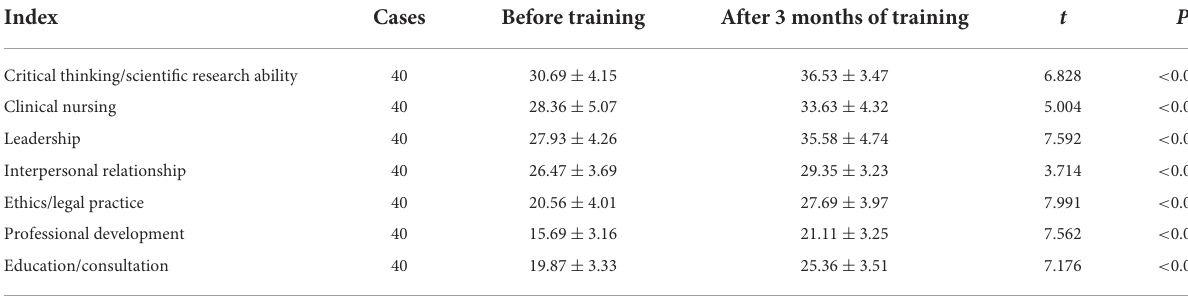
TABLE 2 Comparison of nurses’ comprehensive ability scores before and 3 months after training ( ¯ x ± s, scores). Index